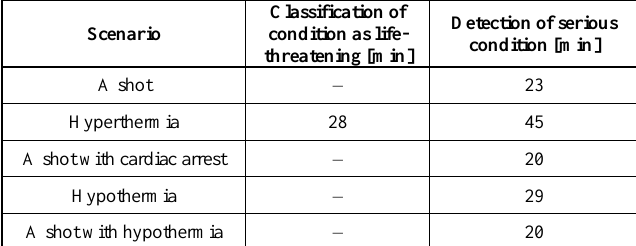
Table 3. Test results – time range of